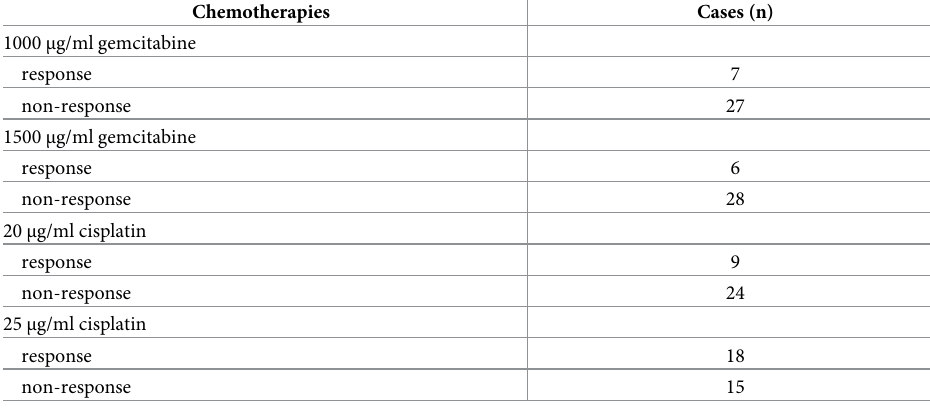
Table 3. The ability of gemcitabine and cisplatin to inhibit tumor tissue growth.